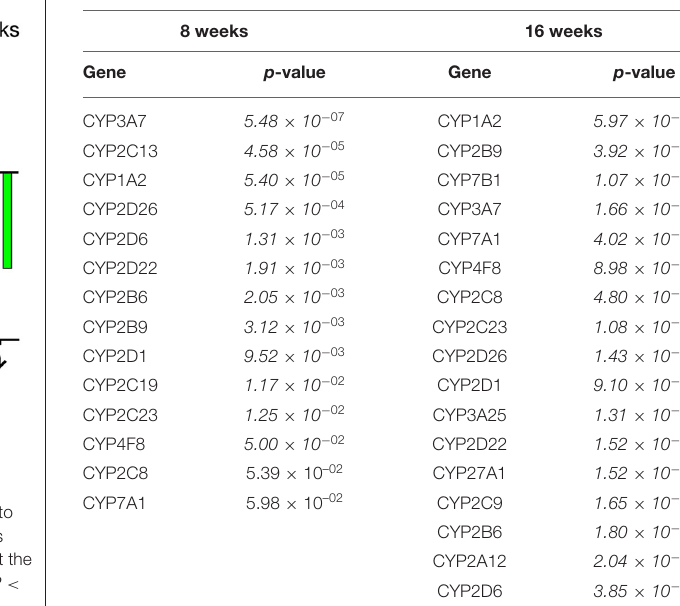
TABLE 3 | Upregulated CYP expression comparison between SPI versus CAS feeding at 8 and 16 weeks of diet.